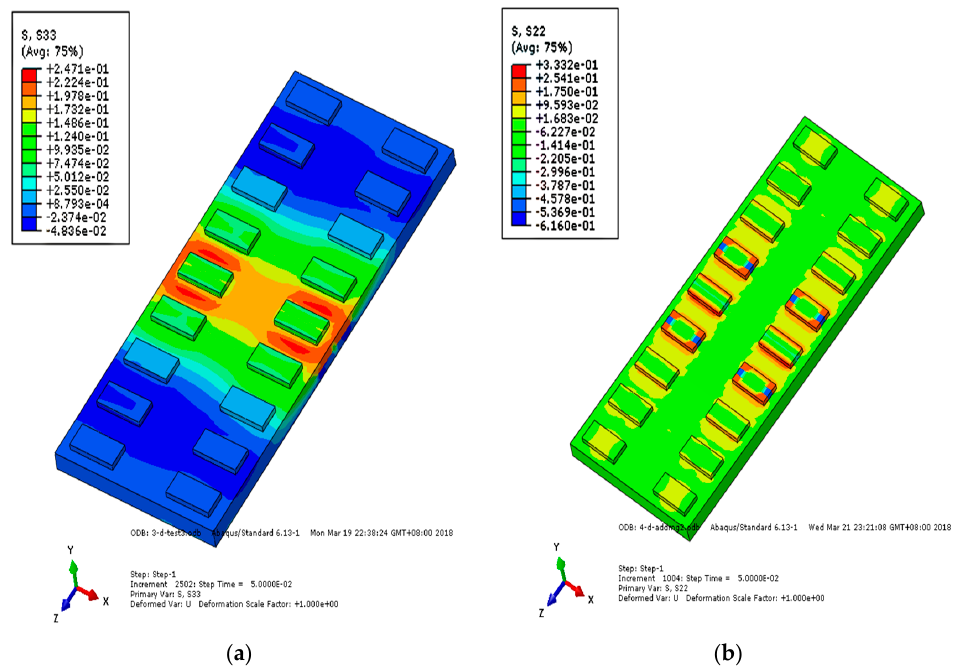
Figure 15. Stress nephogram of track slab under the action of axle falling: ( a ) longitudinal stress of track slab; ( b ) vertical stress of track slab.